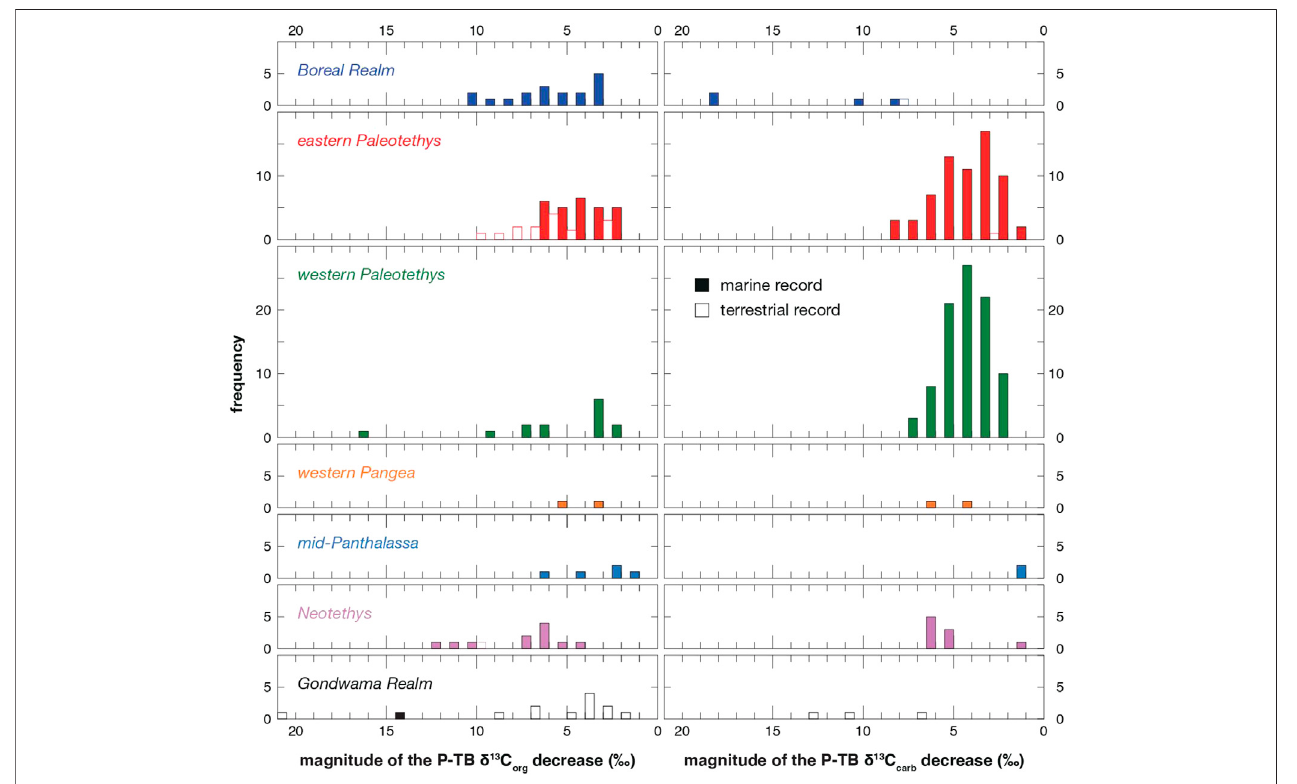
FIGURE 7 | Frequency histogram of the magnitude of the P-TB δ 13 C decrease in various regions.